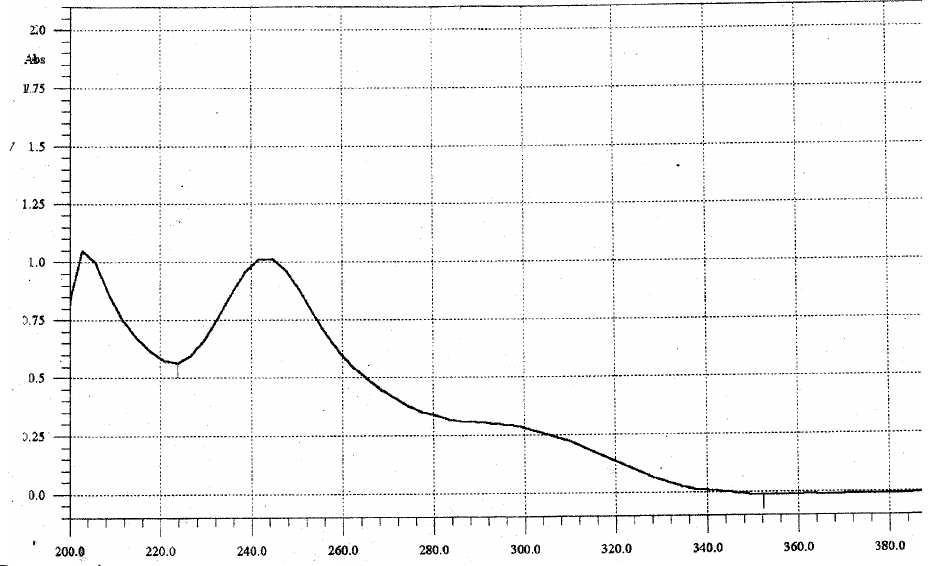
Figure 1. Rosuvastatin scanned in UV range (in